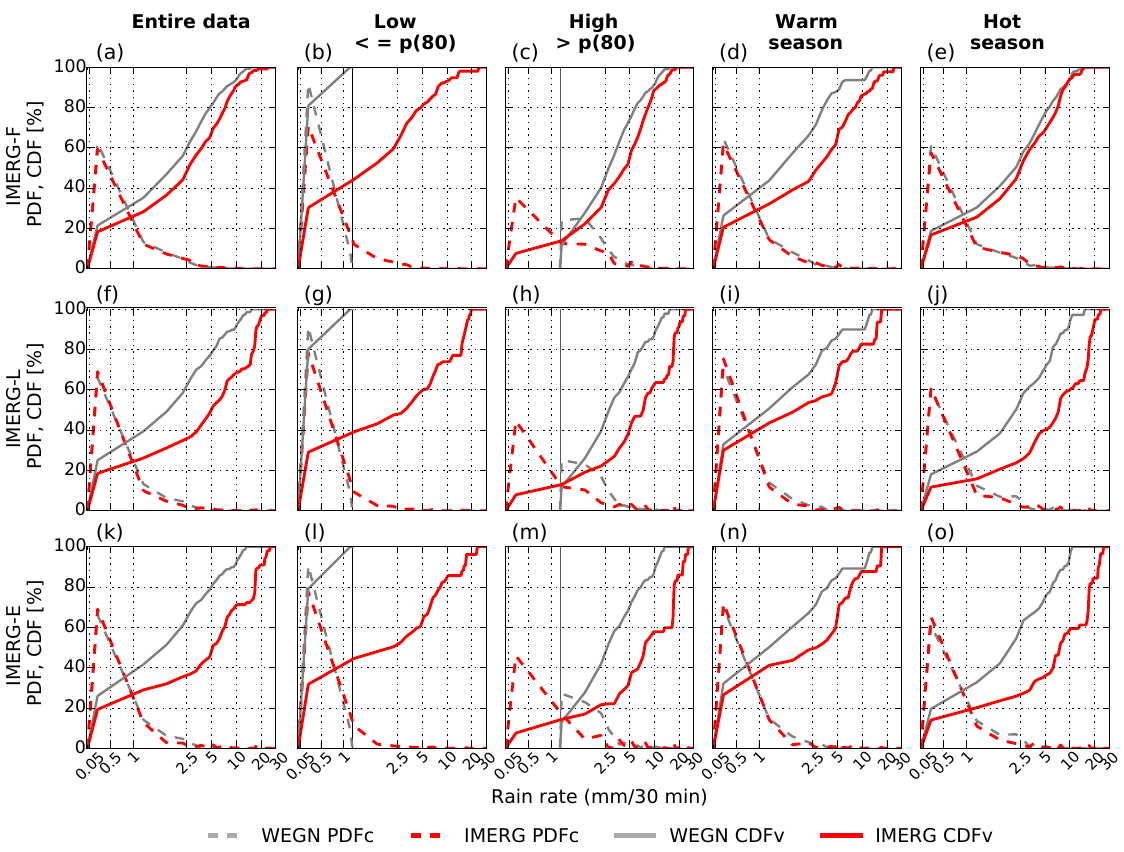
Figure 5. Same layout per panel as Fig. 4, but restricted to the data pairs for which IMERG and WEGN both detected rainfall ( ≥ 0.05mm30min − 1 ). Comparisons are shown for IMERG-F (a–e) , IMERG-L (f–j) , and IMERG-E (k–o) , using the entire data (a, f, k)